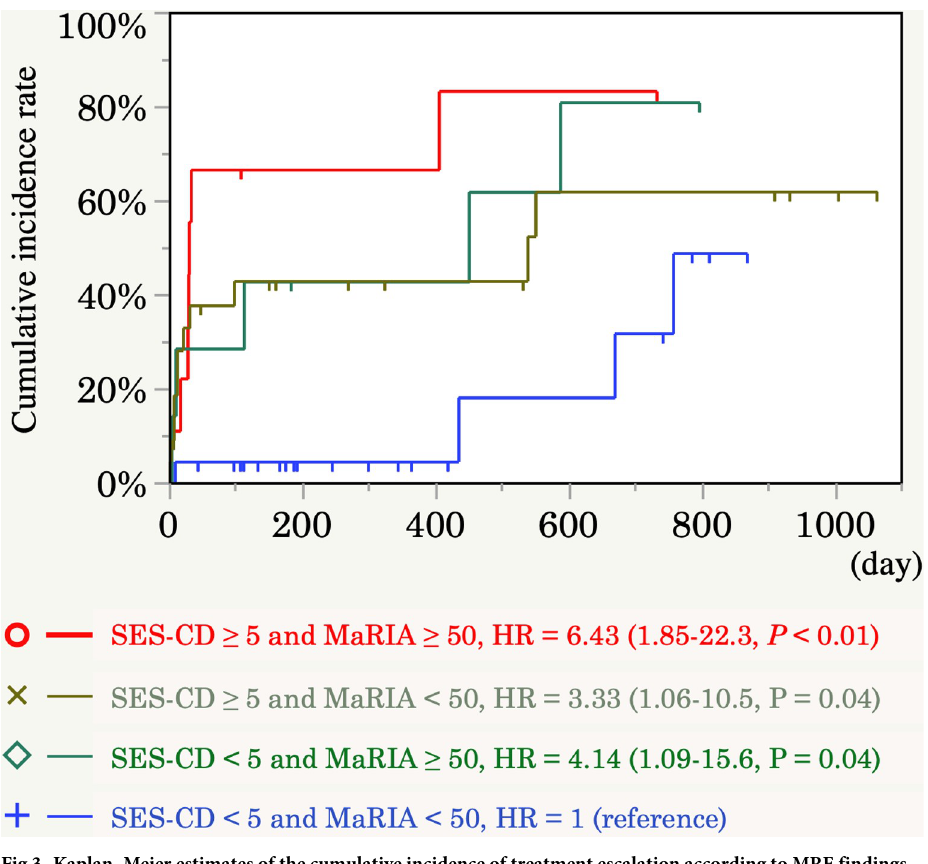
Fig 3. Kaplan–Meier estimates of the cumulative incidence of treatment escalation according to MRE findings and endoscopic findings. Probability of treatment escalation according to active disease in both ileocolonoscopy and MRE (red line, n = 9), active disease only in MRE (green line, n = 7), active disease only in ileocolonoscopy (gray line, n = 22), or remission in both ileocolonoscopy and MRE (blue line, n = 22). A low MaRIA score was associated with a longer incidence-free duration even in patients with endoscopic remission. Hazard ratio (HR) with 95% confidence interval (CI) and P value are shown. Blue line (both remission finding in SES-CD and MaRIA) represents control group).